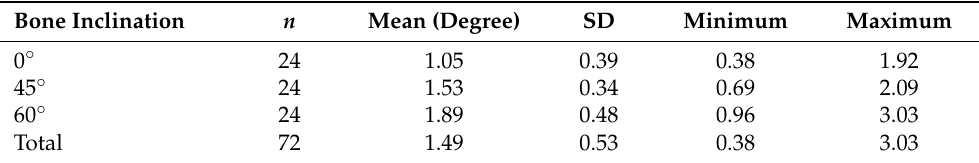
Table 8. Results of descriptive statistics of angular deviation in varying bone inclinations.